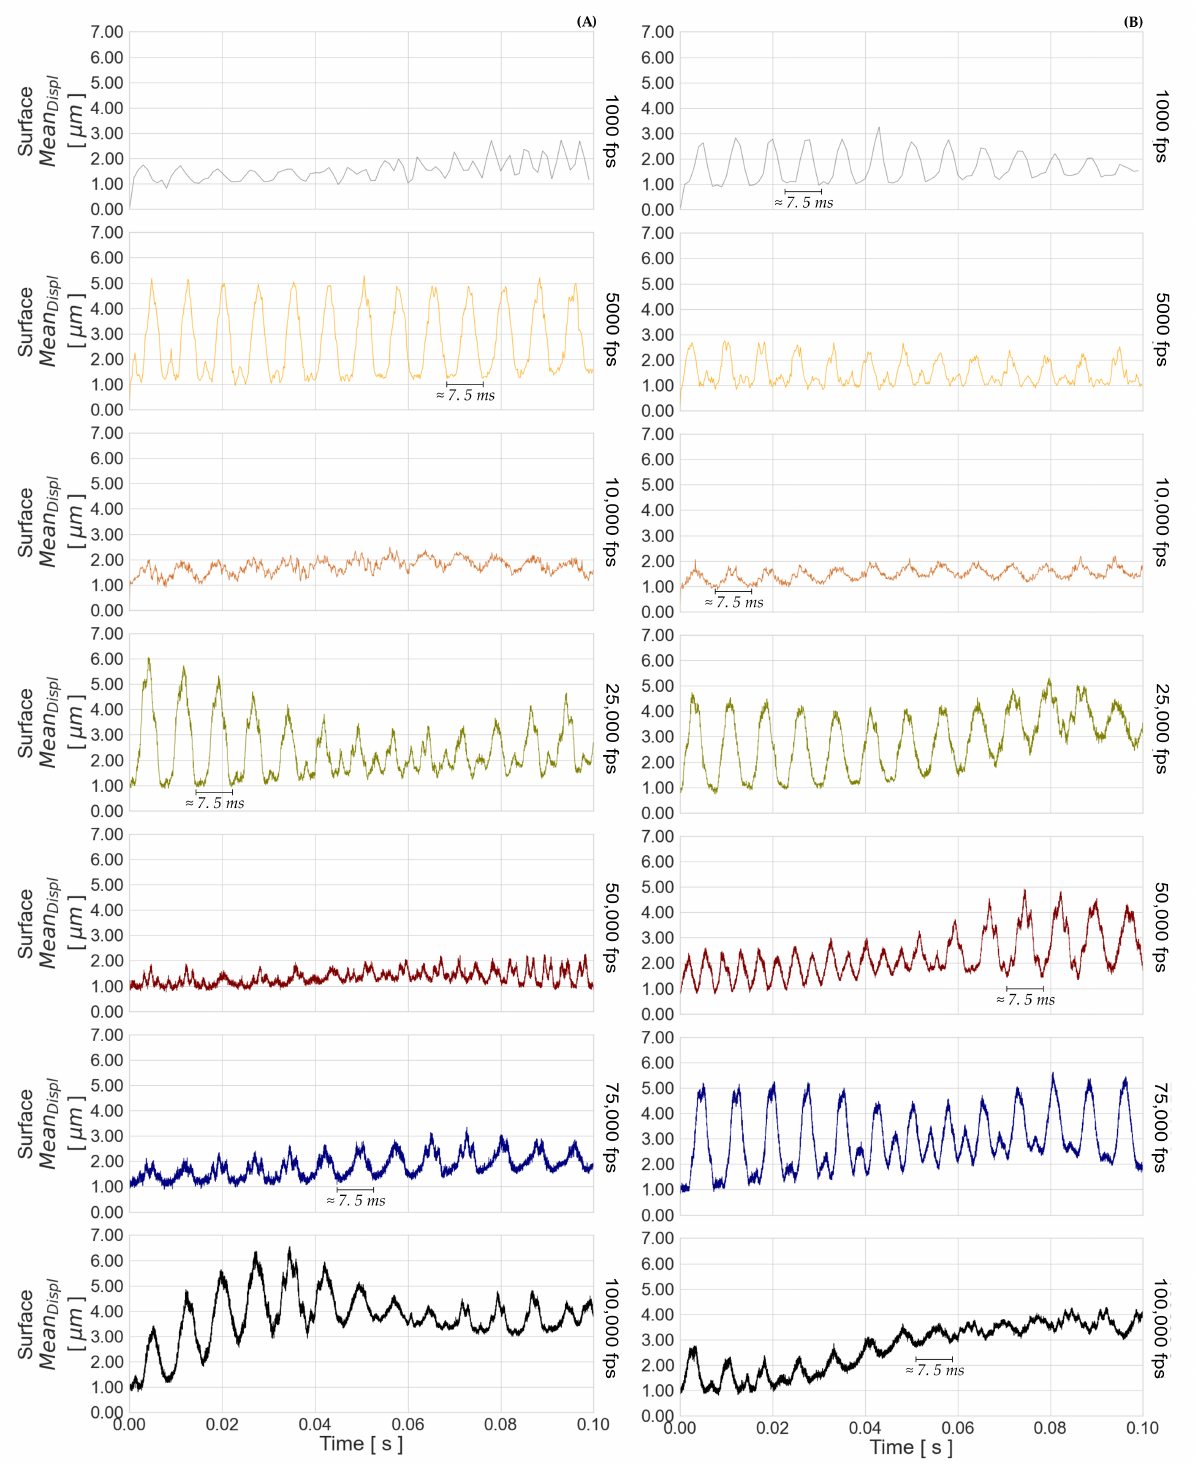
Figure 18. Apparent displacement ( DXYZ ) of the surface for ( A ) RP 06 and ( B ) SP